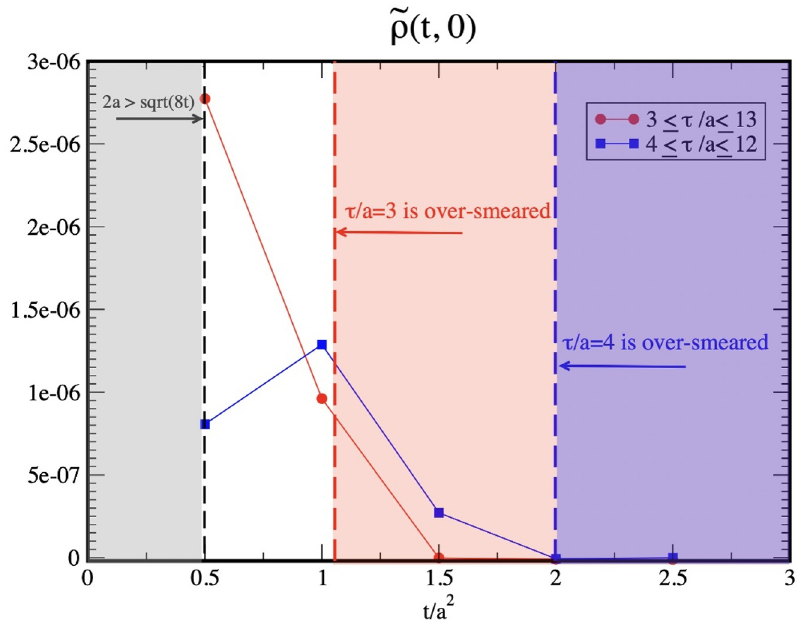
Figure 10 . The (cid:13)ow-time and (cid:28) -regime dependence of ~ (cid:26) ( t; ! = 0). The (cid:12)ducial window (2 a < p 8 t < (cid:28) ) is indicated by the dashed lines. 0 : 50 < t=a 2 < 1 : 12 (non-shadowing) is the (cid:12)ducial window for the 3 (cid:20) (cid:28)=a (cid:20) 13 analysis, while 0 : 50 < t=a 2 < 2 : 00 (non-shadowing and red-shadowing) depicts the one for the 4 (cid:20) (cid:28)=a (cid:20) 12